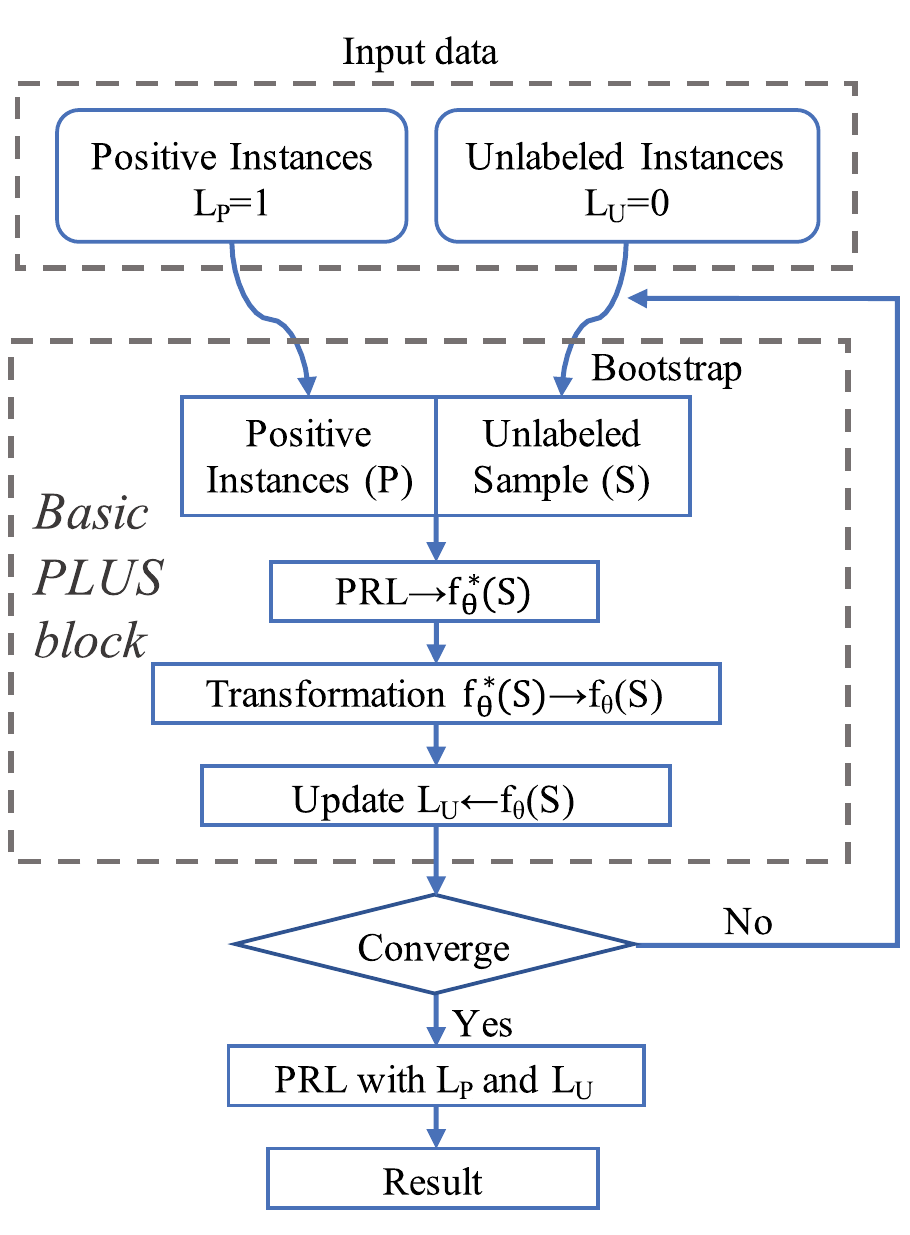
Fig 5. A schematic plot of the PLUS